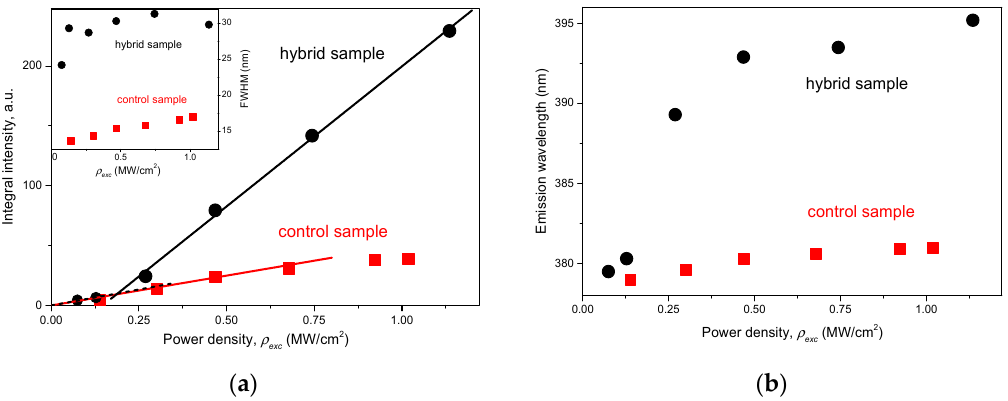
Figure 5. Dependences of the integral intensity ( a ) and wavelength in maximum ( b ) of NBE emission for the hybrid (black) and control (red) samples on ρ exc . Lines represent linear fitting; in the case of the hybrid sample, there are two linear parts—before (dashed line) and after (solid line) the SE threshold. The inset in ( a ) shows FWHM of the emission peaks of the samples vs. ρ exc .